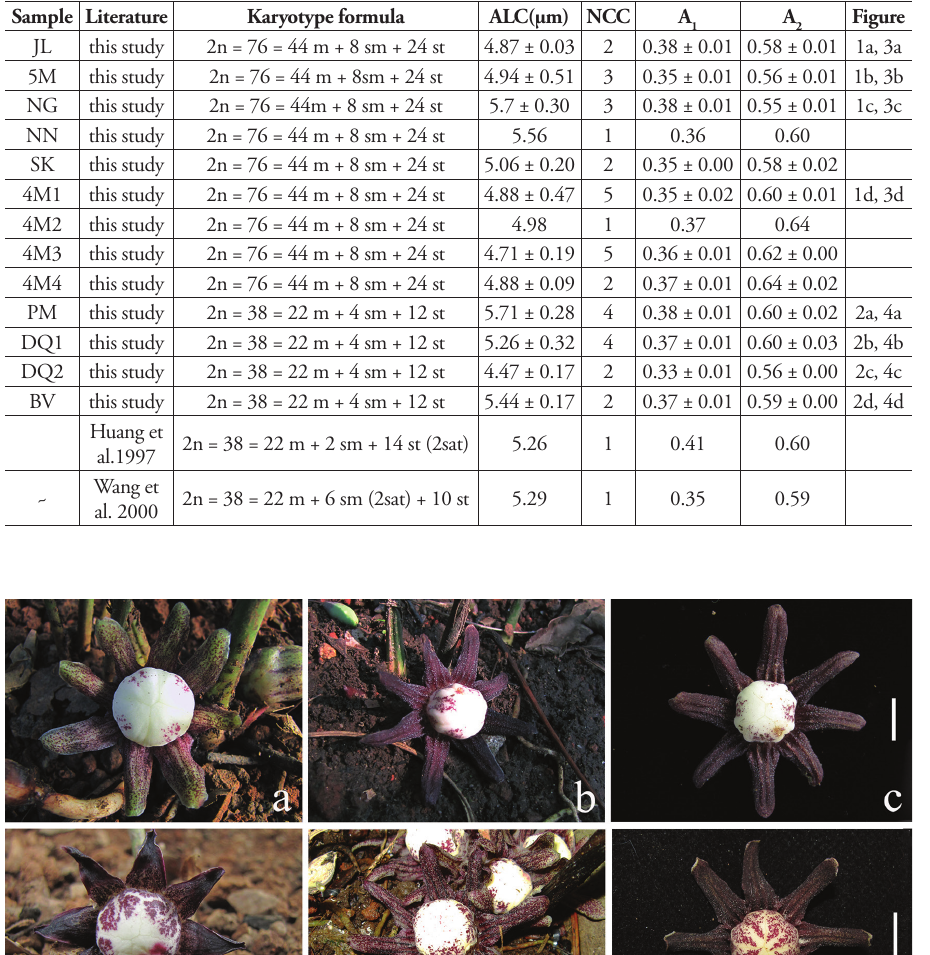
Table 2. Karyomorphological characters in Aspidistra subrotata . ALC = average length of chromosome, NCC = number of cells calculated, A type interchromosomal asymmetry index.